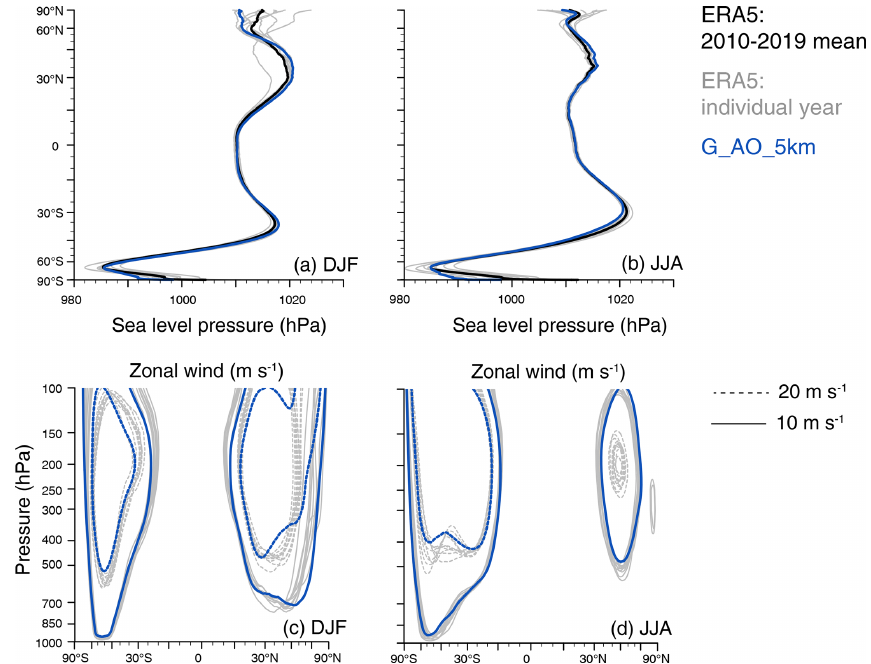
Figure 5. Meridional cross-sections of zonally averaged sea level pressure (hPa) for (a) DJF and (b) JJA as well as height–latitude cross- sections of zonal wind velocity (ms − 1 ) for (c) DJA and (d) JJA from ERA5 (grid spacing of 30km) and G_AO_5km. In G_AO_5km, DJF is the mean from December 2020 to February